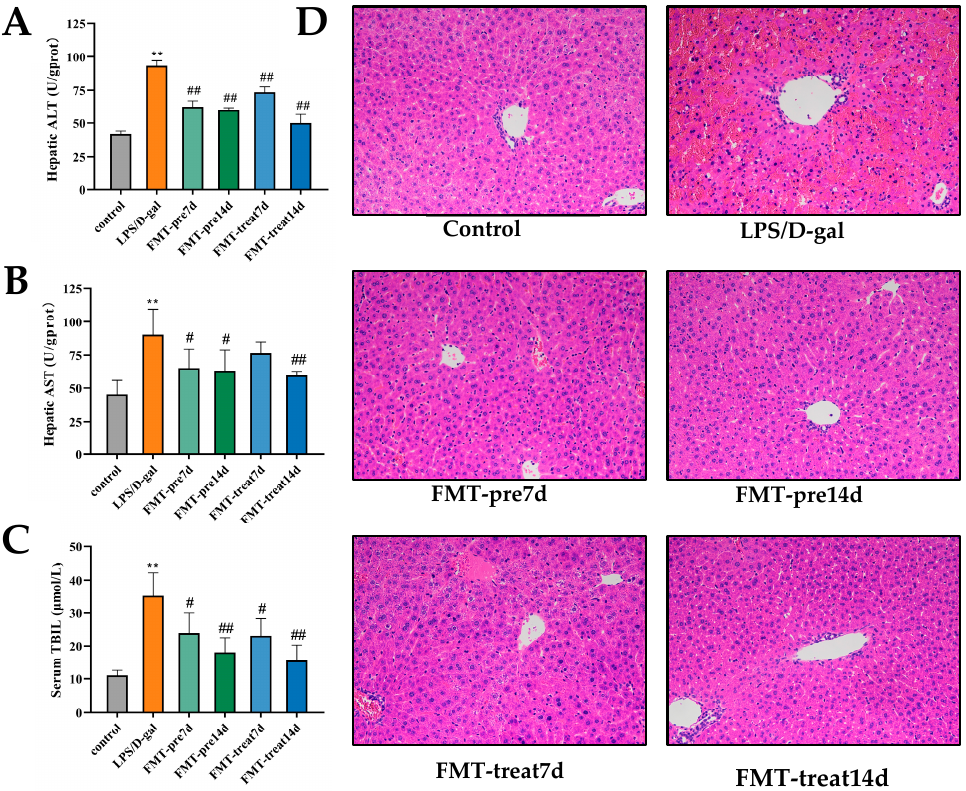
Figure 1. FMT relieved LPS/D-gal-induced acute liver failure (ALF) in mice. ( A , B ) Hepatic levels of alanine aminotransferase (ALT) and aspartate aminotransferase (AST) ( n = 6 in each group). ( C ) Serum level of total bilirubin (TBIL) ( n = 6). ( D ) Representative images of H and E staining of liver sections (magnification × 200). ** p < 0.01 vs. control group, # p < 0.05, ## p < 0.01 vs. LPS/D-gal group. Dates were expressed as means ± SEM.